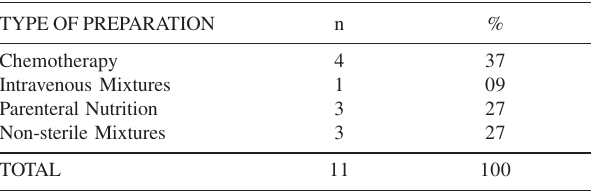
Table 4 - Types of preparations manipulated at the Hospital Pharmacy,